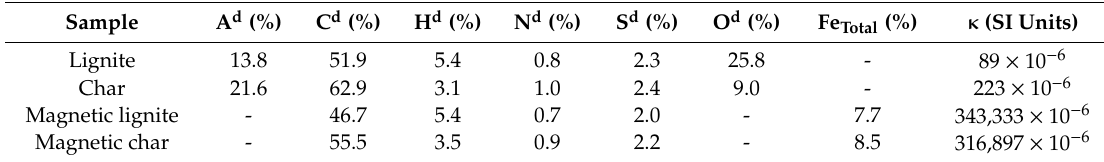
Table 1. Elemental (CHNS) analysis, ash content, total iron content, and volumetric magnetic susceptibility ( κ ) of the initial samples (lignite and char) and the samples after high-energy ball milling (magnetic lignite and magnetic